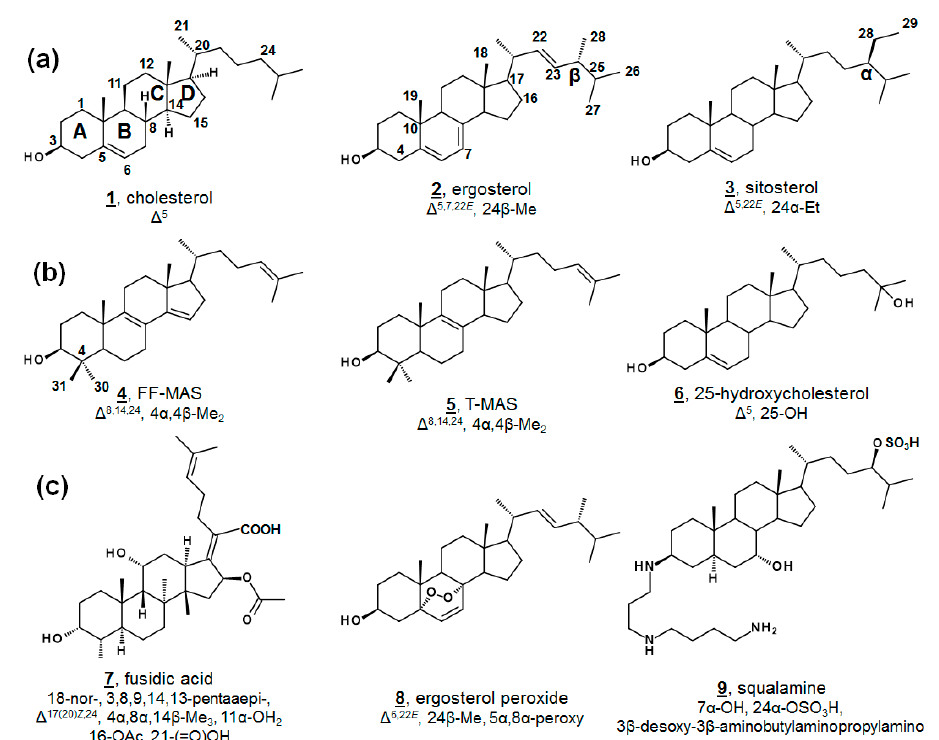
Figure 1. Structure and numbering systems of sterols and steroids. ( a ) ∆ 5 end product inserts from mammals, fungi, and vascular plants, respectively, cholesterol 1 , ergosterol 2 , and sitosterol 3 . ( b ) Examples of steroidal metabolites important in human biology for F-MAS 4 , TT-MAS 5 , 25-hydroxycholesterol 6 . ( c ) Examples of steroidal metabolites from nonhuman sources with bioactivity, fusidic acid 7 , ergosterol peroxide 8 , and squalamine 9 . The numbering system shown here, and used in this manuscript, is the conventional system [1]. Designations of α and β within the sterol nucleus signify below and above the plane. Unrelated to nucleus α and β , substituents on C24 are also designated α and β to reflect the C24 stereochemistries of sitosterol and ergosterol, respectively, as drawn above. Carbon numbering is provided on 1–4, and stereochemistries at C8, C9, C14, and C16 on structure 1 are hereafter implied on structures, unless otherwise annotated as in fusidic acid. Molecular features for each structure are provided relative to 5 α -cholestanol for clarity. For a complete list of systematic names of compounds, see Table A1.